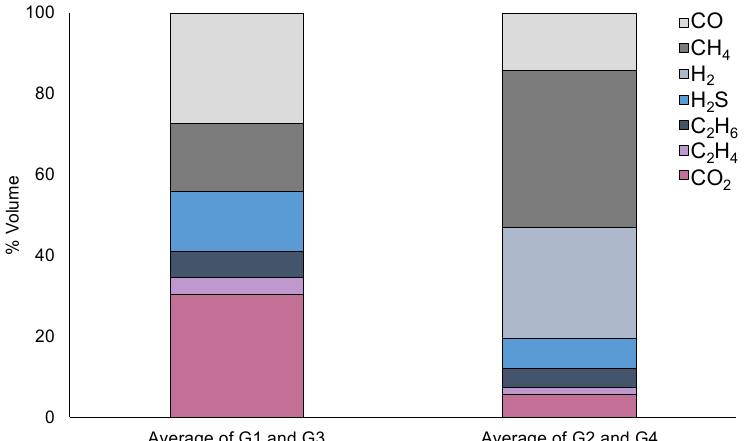
Figure 10. Gas fraction composition on a nitrogen-free basis of pyrolysis of waste tire powder without chemical activation (average of G1 and G3) and pyrolysis of chemically activated waste tire powder (average of G2 and G4). Note: Gas produced during physical activation was not considered.